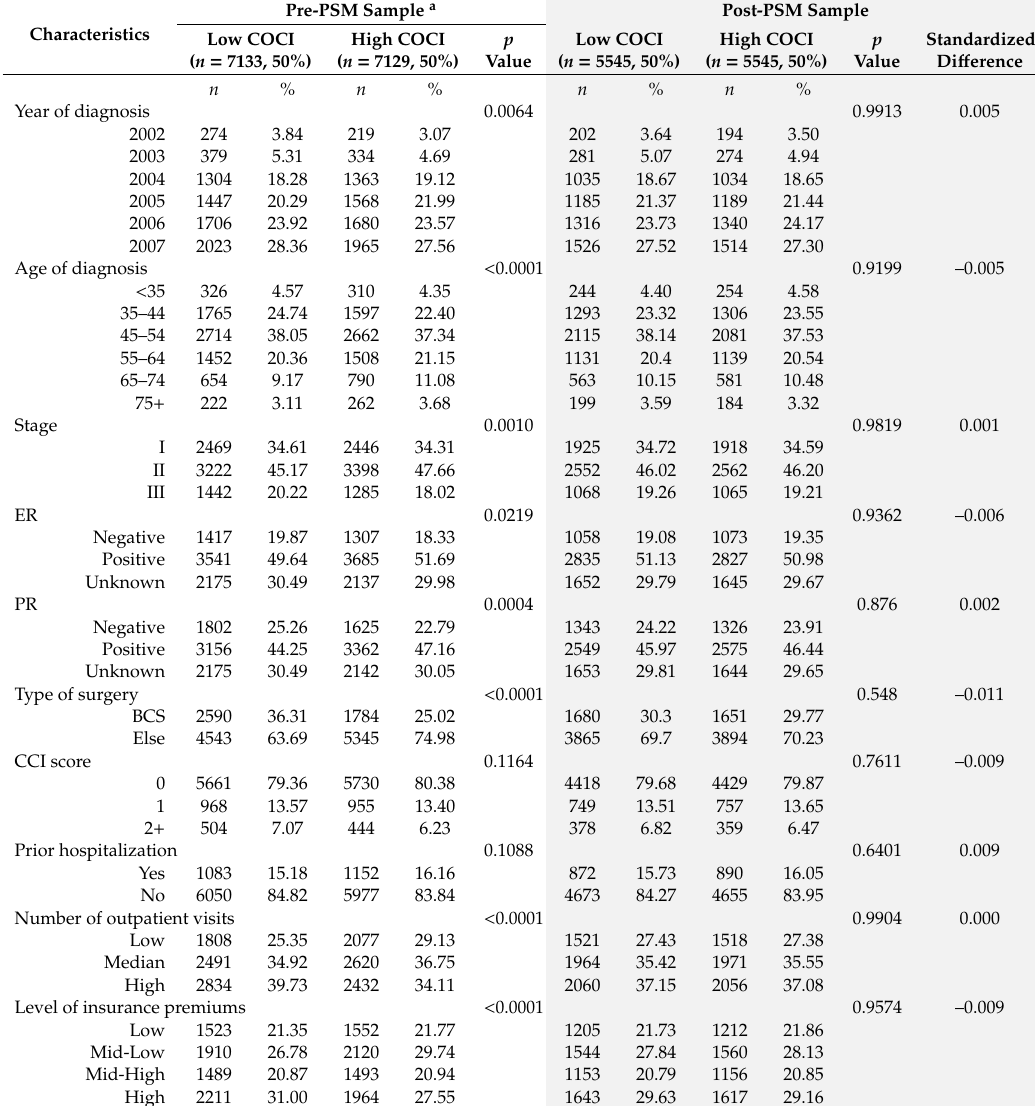
Table 1. Baseline characteristics of patients grouped according to the oncology continuity of care.